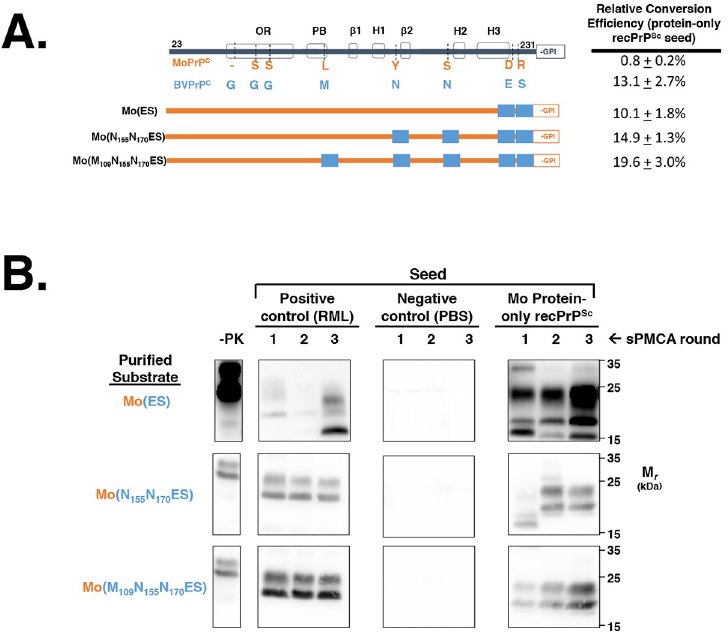
Fig 5. Determining the BV amino acids that are sufficient to propagate protein-only recPrP Sc . (A) Table summarizing the ability of BV/Mo PrP C chimeras to propagate Mo protein-only recPrP Sc . All constructs are based on the Mo PrP C backbone and become progressively substituted with BV residues from the C-terminus towards the N-terminus. (B) Western blots of experiments summarized in (A), showing three-round reconstituted sPMCA reactions using partially purified PrP C substrates supplemented with PrP 0/0 BH and initially seeded with various seeds, as indicated. -PK = samples not subjected to proteinase K digestion; all other samples were proteolyzed.